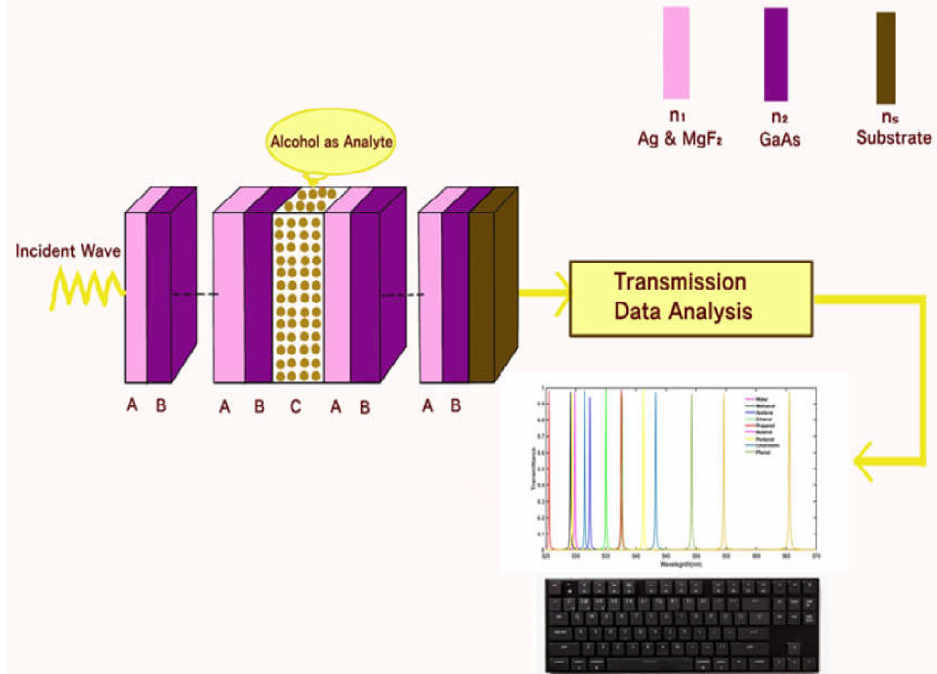
Figure 1. The architecture of the proposed 1D bio-alcohol sensor composed of 1D PCs with defect layer C sandwiched between the two layers B and